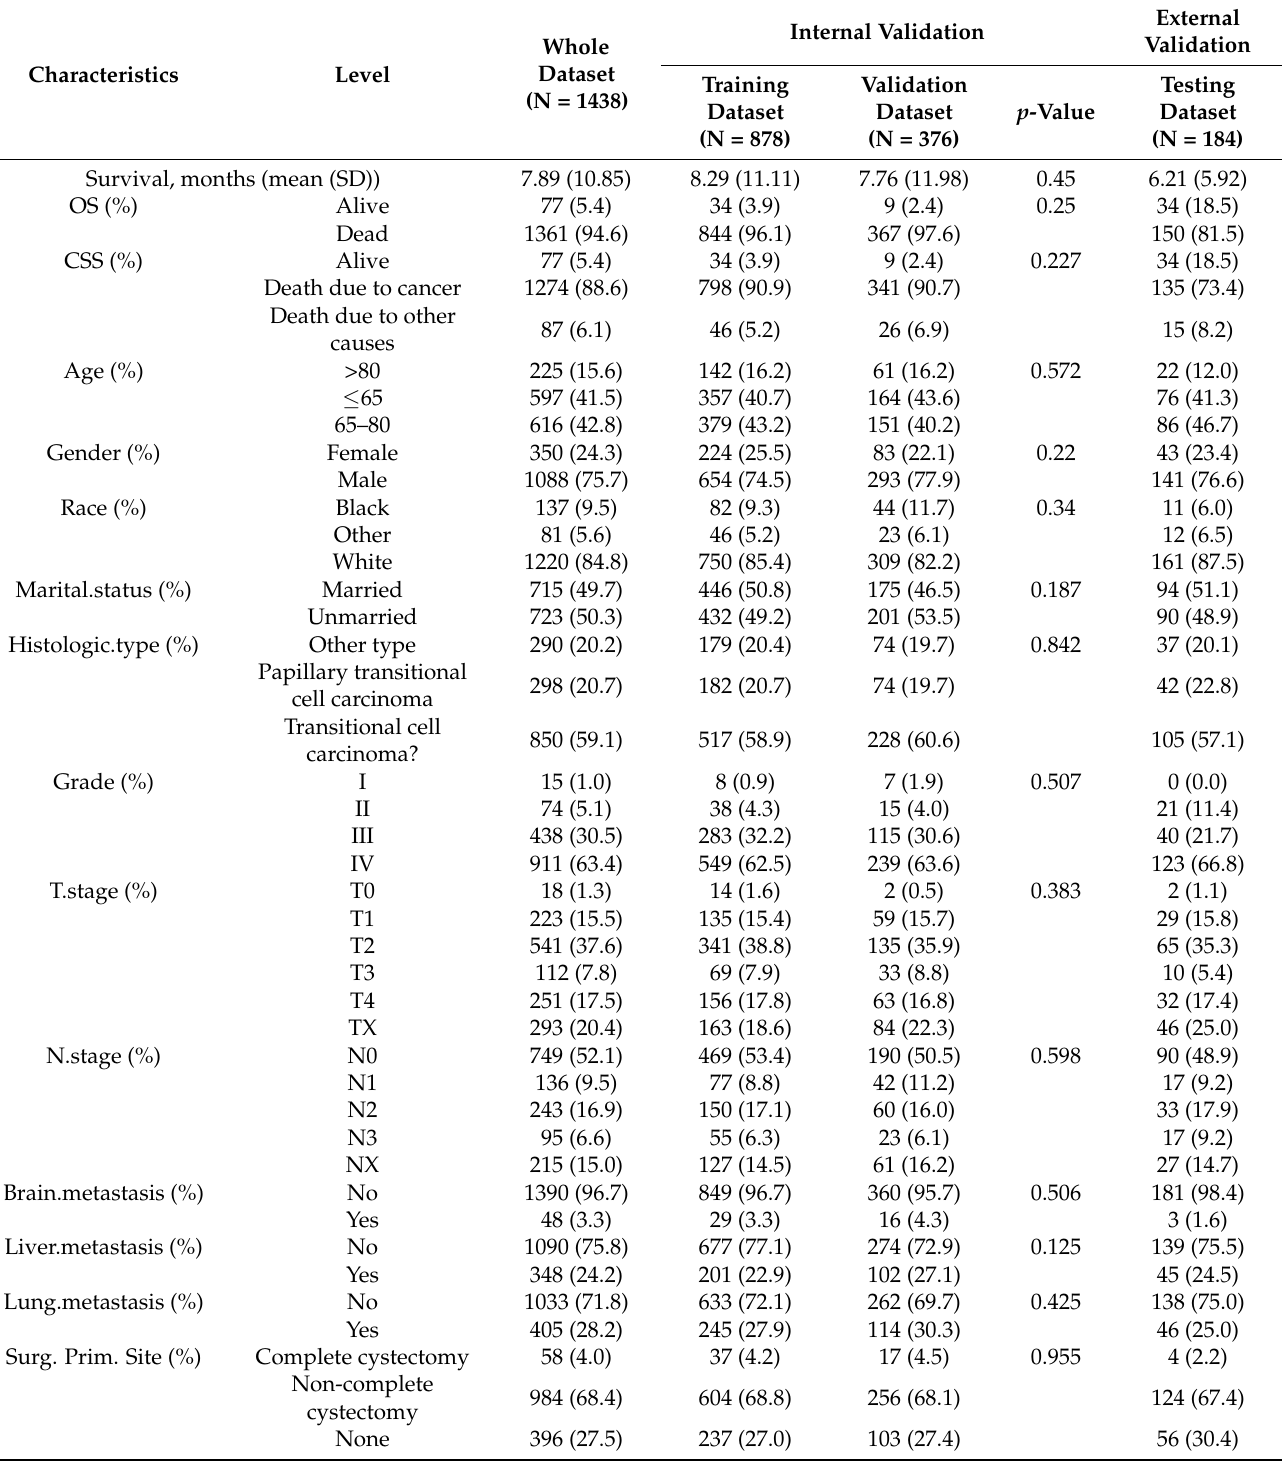
Table 1. Characteristics of patients in the training dataset, the validation dataset, and the testing